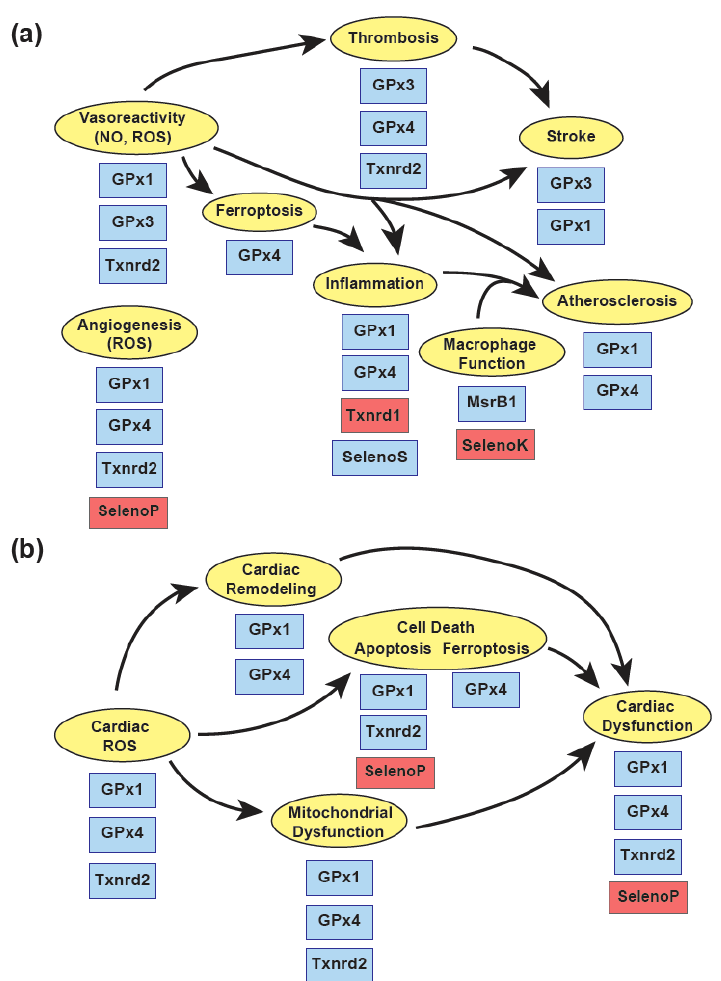
Figure 3. Role of selenoproteins in cardiovascular protection. ( a ) Vascular function. Selenoproteins regulate normal vascular functions, such as vasoreactivity, via their ability to reduce harmful reactive oxygen species (ROS) and preserve bioavailable nitric oxide (NO). Selenoproteins (in blue) also prevent adverse responses such as thrombosis, ferroptosis, inflammation, and thrombosis to prevent diseases such as stroke and atherosclerosis. The actions of Selenoprotein P (SelenoP) and Selenoprotein K (SelenoK) are not protective, as they inhibit angiogenic responses and promote atherogenic macrophage functions, respectively. The actions of Txnrd1 promotes pro-inflammatory signaling via NFkB. Note the effects of GPx4 on vascular NO has not been examined. ( b ) Cardiac function. The selenoproteins (in blue) are protective against cardiac remodeling, cell death, mitochondrial and cardiac dysfunction, except for SelenoP which promotes apoptosis and cardiac dysfunction, as discussed in the text. The effect of SelenoP on cardiac ROS has not been